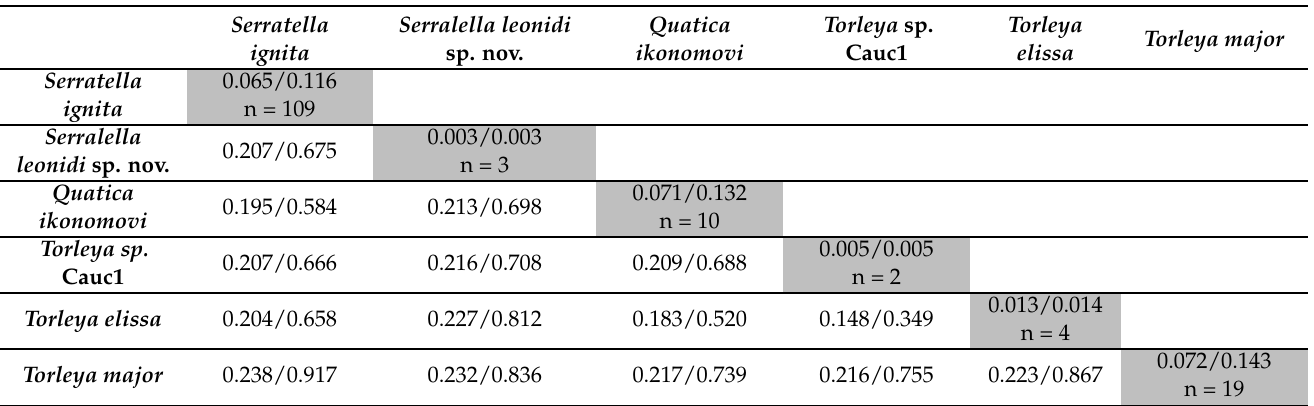
Table 2. Genetic distances (COI) between sequenced Hyrtanellini species, which occur in Western and Central Asia, and within the species calculated using the Kimura 2-parameter (K2) model and Tamura 3-parameter (T92) model with a gamma distribution (G) (K2/T92+G). N—number of used